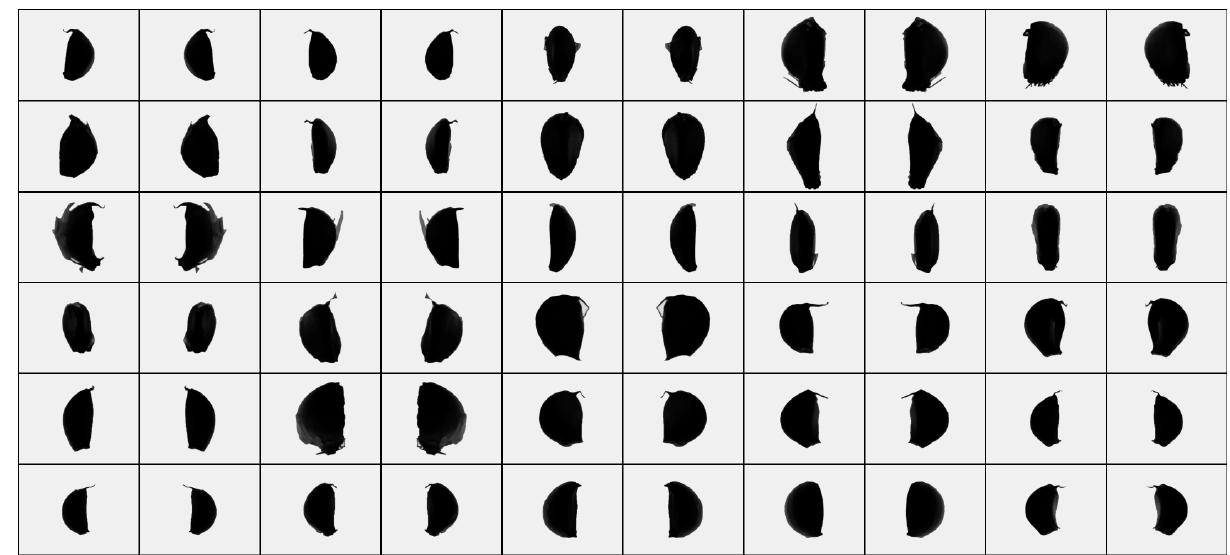
Figure 5. Horizontal reversal amplification sample.